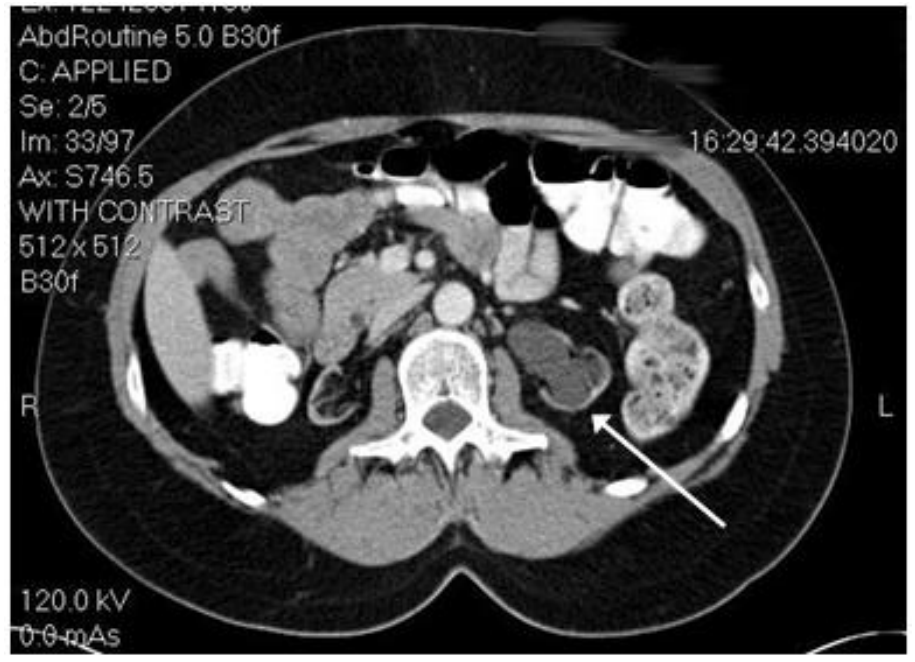
FIGURE 1. Initial CT of abdomen and pelvis demonstrated severely atrophic bilateral native kidneys with severe left-sided